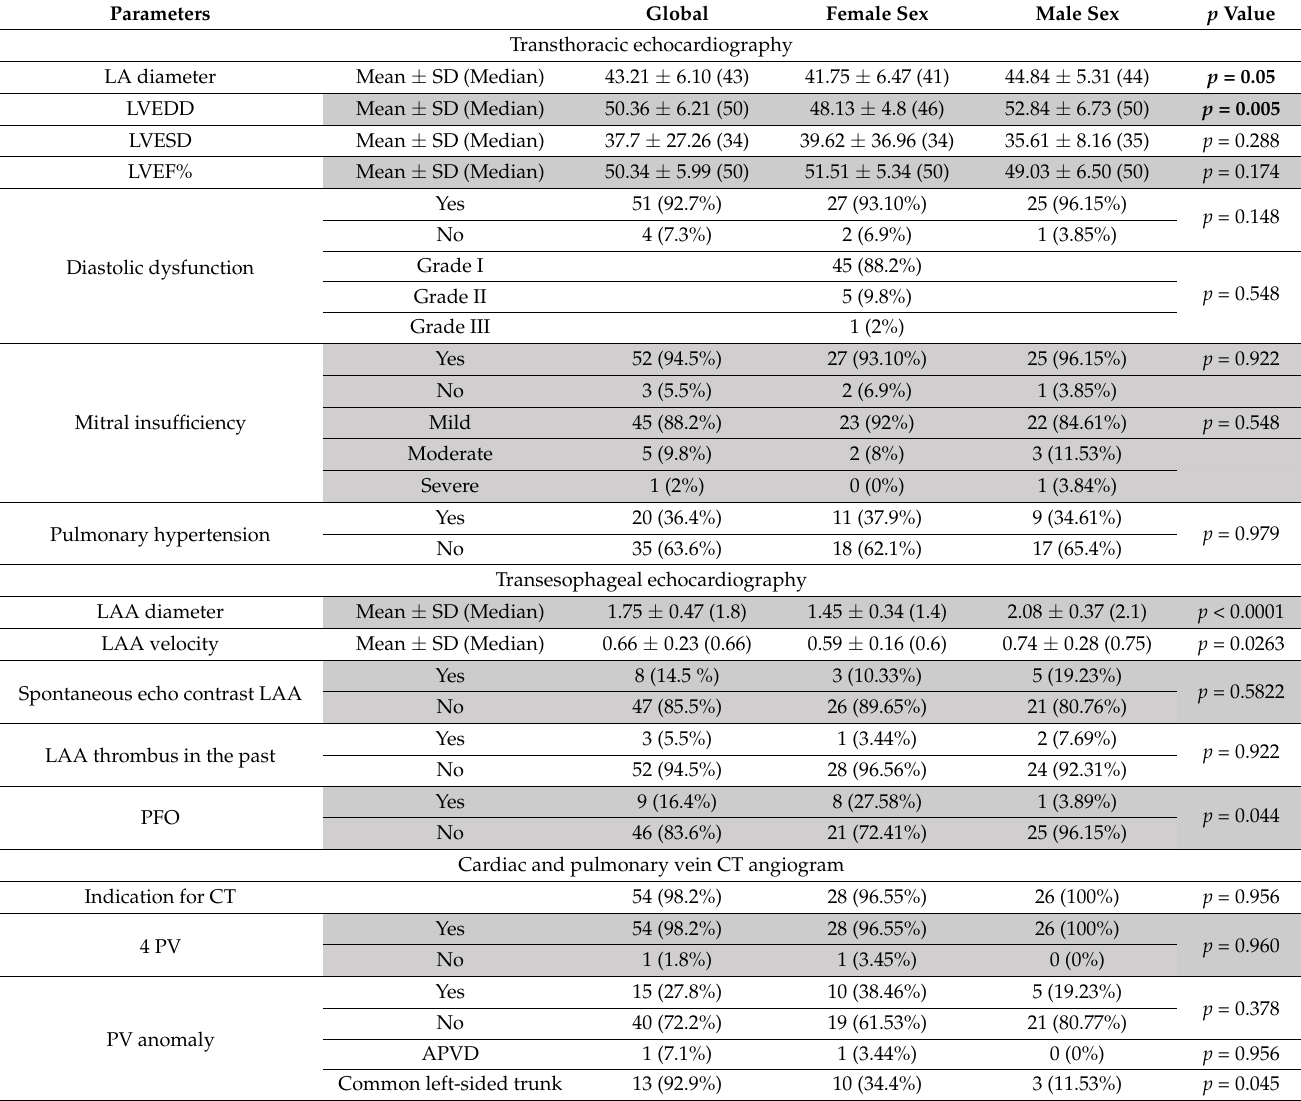
Table 2. Echocardiographic and imaging parameters evaluated before performing atrial fibrillation catheter